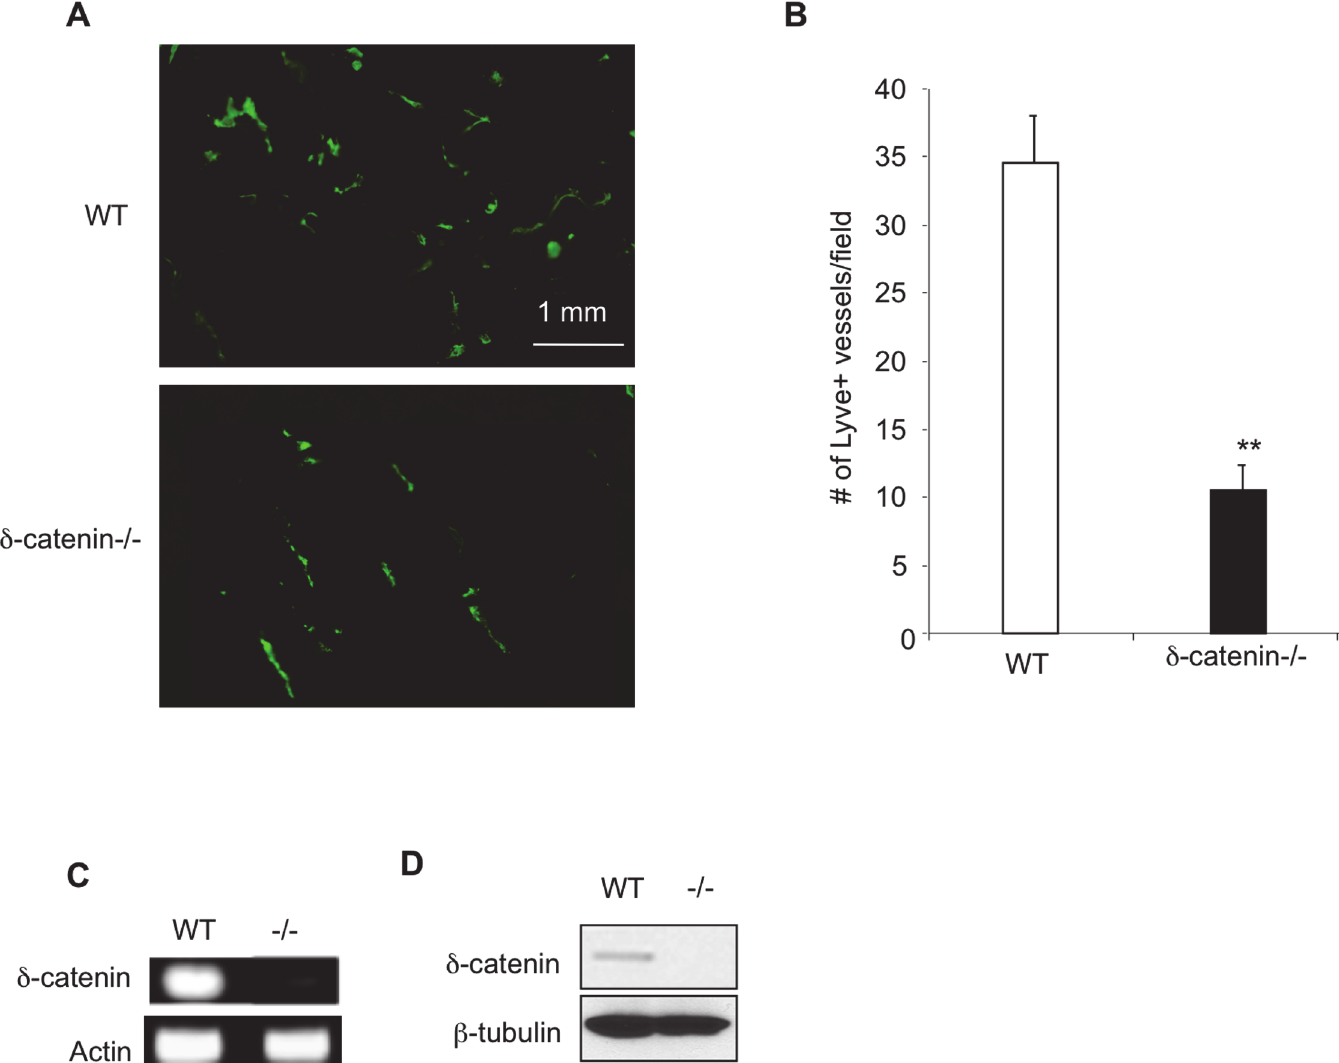
Figure 3. Deletion of δ -catenin in mouse impairs lymphangiogenesis in vivo . Recombinant VEGF-C at 100 ng was mixed with 100 μ l of ice cold Matrigel, and injected sc into the dorsal skin region in age and sex matched wild type and δ -catenin null mice (2 injections per mouse). The solidified Matrigel plus was harvested in 2 weeks after the implantation, sectioned and stained with an anti Lyve-1 antibody (Panel A). The number of Lyve-1 positive vascular structures was counted in 10 randomly selected fields under microscopy and graphed (Panel B). n = 8 gel plugs per group. ** p < 0.01. Murine lung lymphatic microvascular endothelial cells were isolated and purified from pooled 7 weeks old wild type and δ -catenin null mice (n = 4 mice per group) by flow cytometry using antibody against Lyve-1. Total RNA was isolated and subjected to RT-PCR with δ -catenin specific primers (Panel C). Cell lysates were analyzed by Western blot and incubated with an antibody specific for δ -catenin (Panel